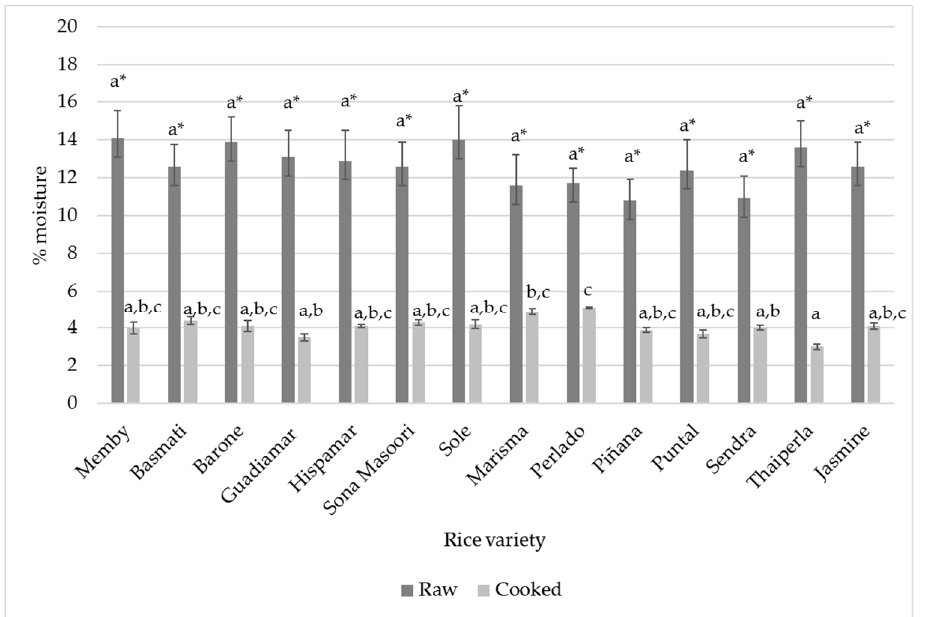
Figure 1. Moisture (%) in raw and cooked rice. Different letters in the same row indicate significant differences by ANOVA test ( p < 0.05). * indicates significant differences between raw and cooked